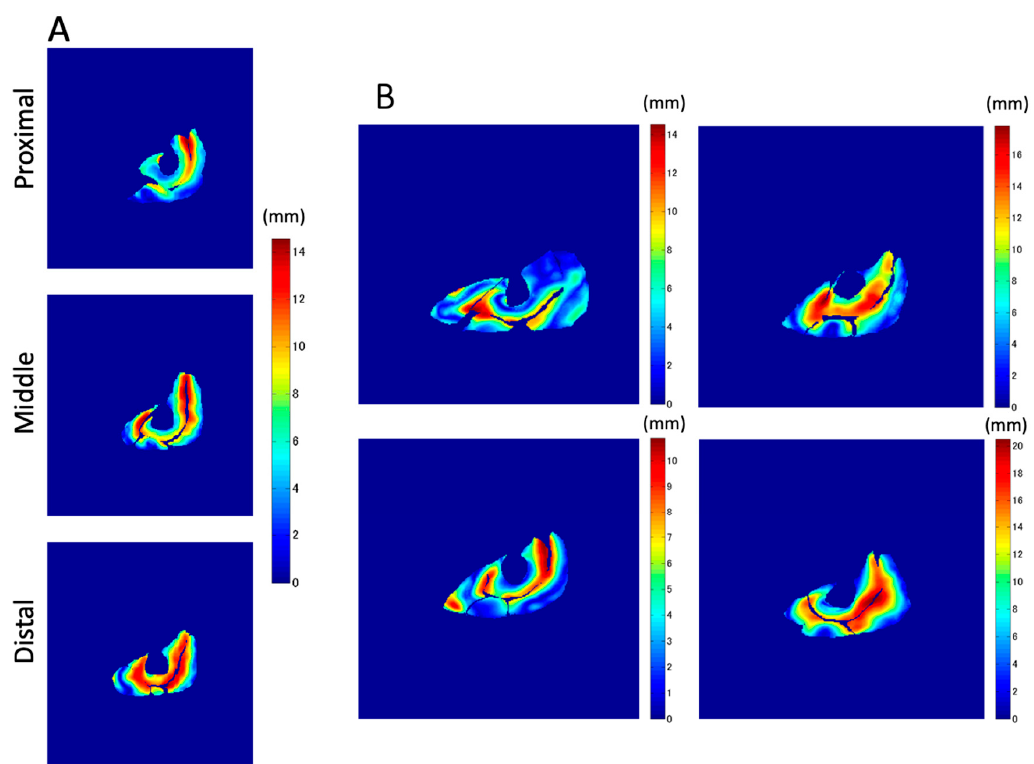
Figure 8. Examples of the Z -axis displacement at pixel level superimposed upon the static anatomical shape. ( A ) The distribution in the three different sections, proximal, middle, and distal in the same subject. ( B ) Examples of the middle section in four different subjects that clearly show all four muscles.